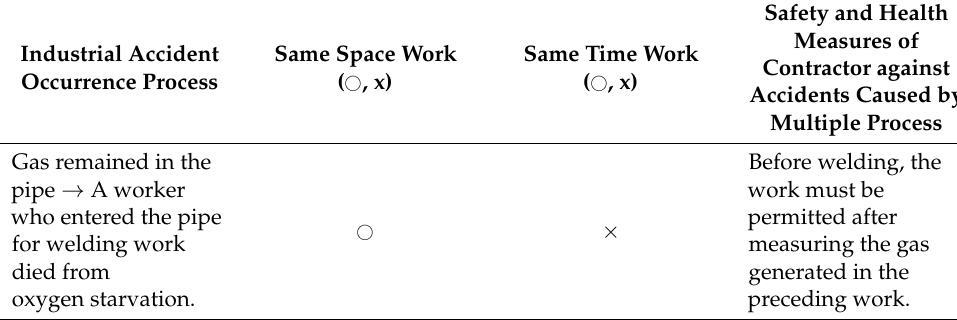
Table 12. Cases of asphyxia or intoxication accidents by multiple processes in the